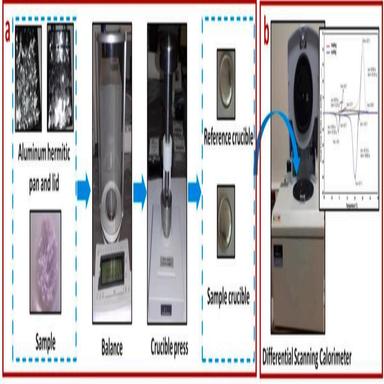
Experimental DSC measurement (reference and crucible preparation (a) and Differential Scanning Calorimeter (b)).